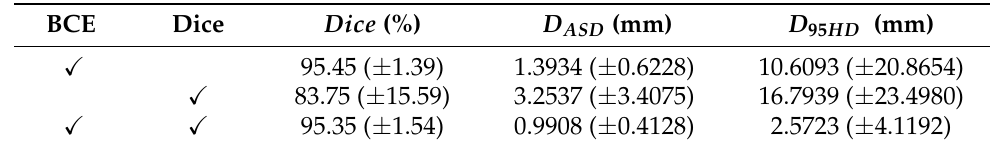
Table 3. Ablation analysis on different loss function settings.